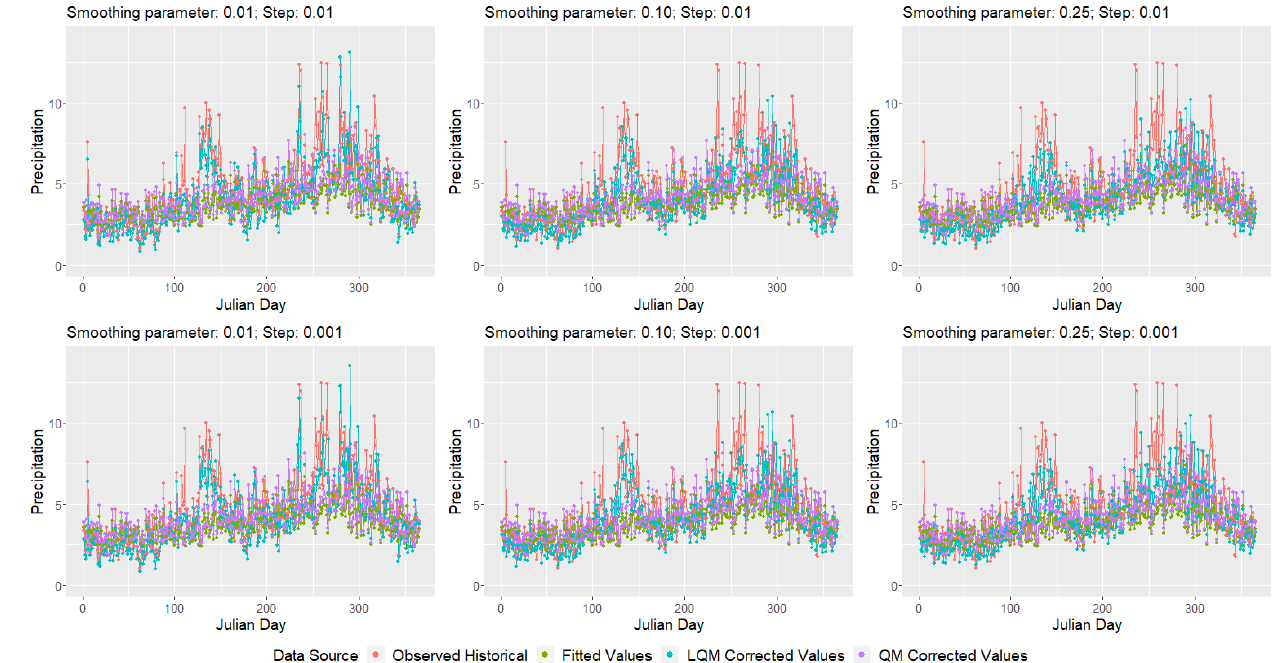
Figure 9. Average precipitation (mm) across all 23 stations from 1980 to 2005 as a function of Julian day for observed values (red), raw fitted values (green), LQM bias-corrected values (blue), and QM bias-corrected values (purple) using Canada’s CanESM2 model at three different LOESS smoothing spans and two different step sizes. This figure was created using Wickham (2016).